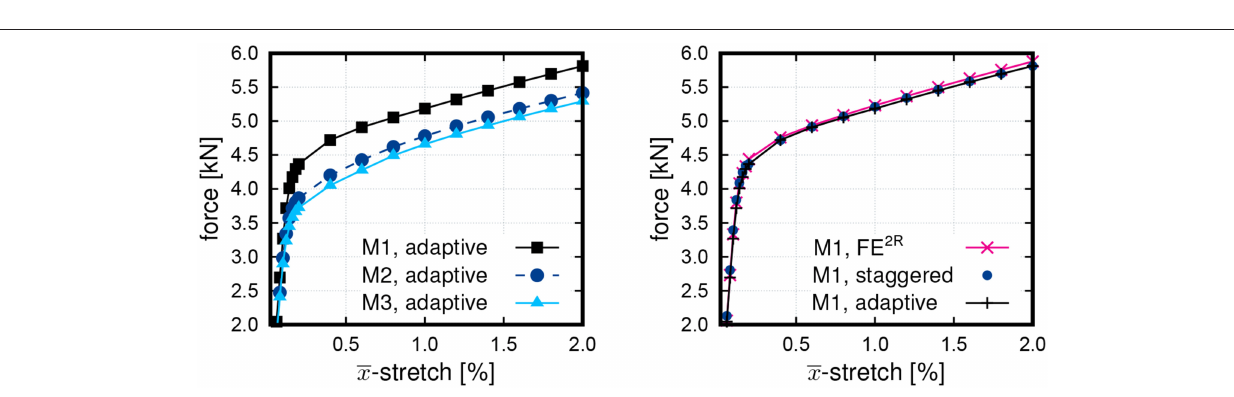
FIGURE 8 | (Left) Comparison of the macroscopic stretch-force relation for the on-the-fly adaptive algorithm for meshes M1–M3; (Right) Comparison for M1: on-the-fly adaptive vs. staggered vs. FE 2R with 32